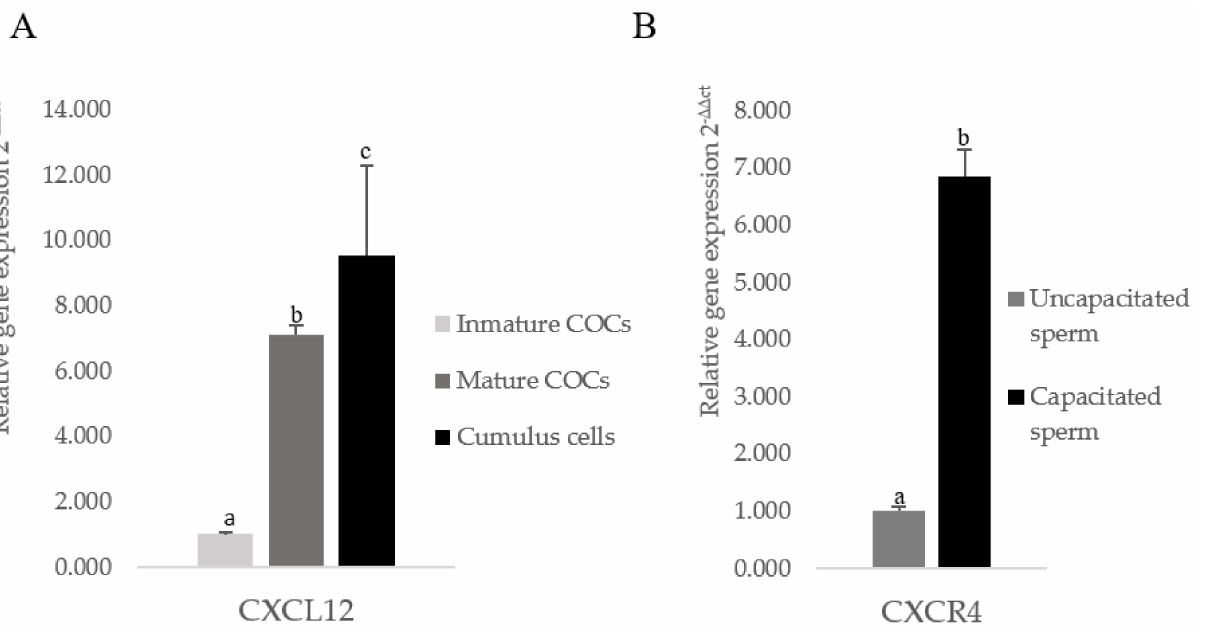
Figure 1. Relative RNA expression of CXCL12 analyzed in the immature and mature cumulus–oocyte complexes (COCs) and cumulus cell ( A ). Relative RNA expression of CXCR4 analyzed in incapacitated and in vitro capacitated spermatozoa ( B ). Data are expressed by mean ± SEM. Columns with different superscripts (a and b) and asterisks indicate significant differences ( p < 0.05) between